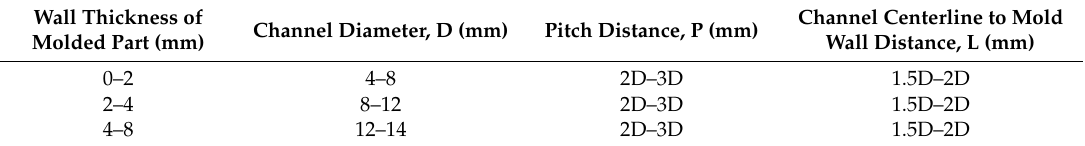
Table 1. Correlation amongst design parameters of conformal cooling channels